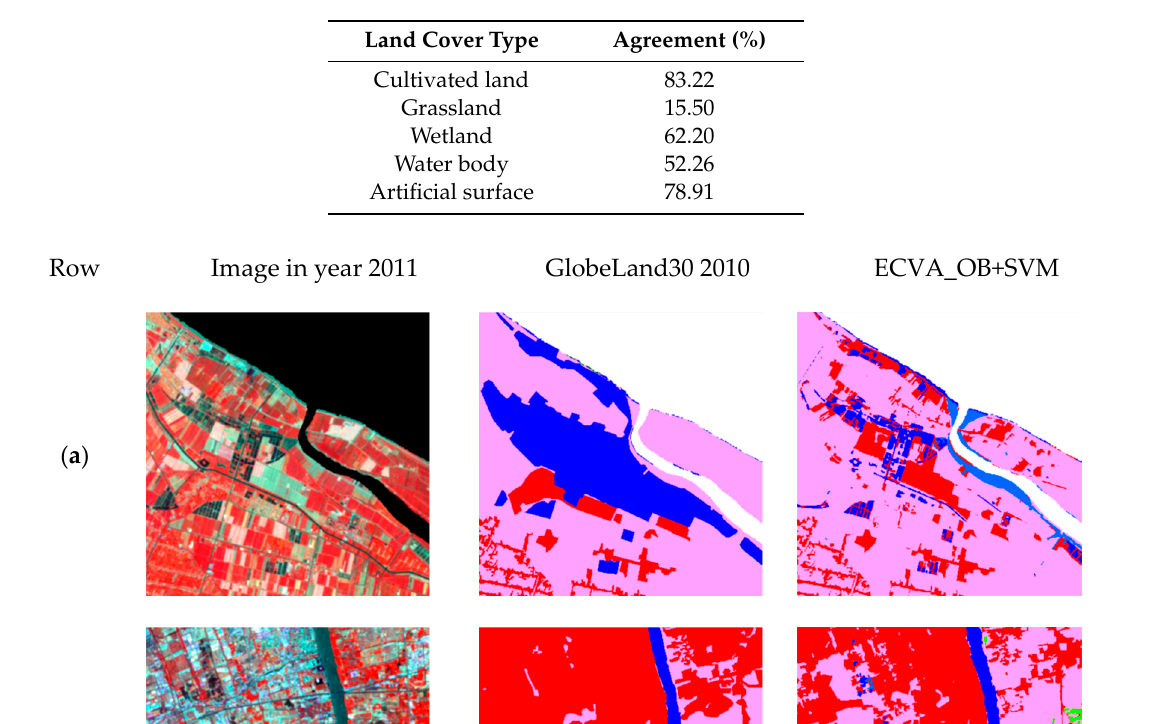
Per-pixel agreement between generated updating result by ECVA_OB + SVM and GlobeLand30 2010.